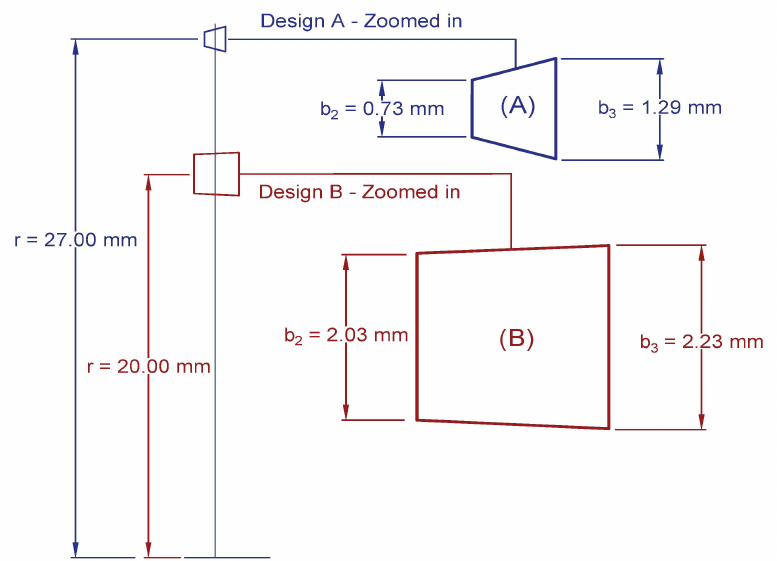
Figure 10. Comparison between two turbine designs at: ( A ) ψ = 1.6, φ = 0.2 and Λ = 0.5; and ( B ) ψ = 3.0, φ = 0.2 and Λ =